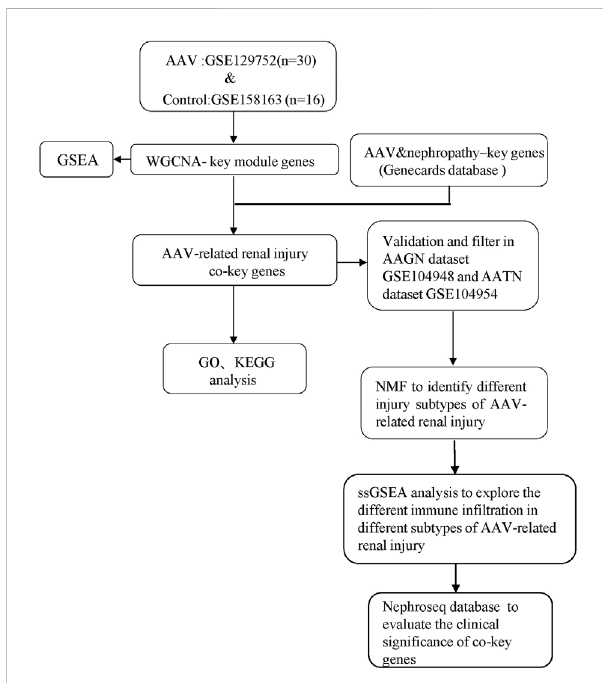
FIGURE 1 Study work fl ow. Anti-neutrophil cytoplasmic antibody – associated vasculitis (AAV), weighted gene co-expression network analysis (WGCNA), gene set enrichment analysis (GSEA), Gene Ontology (GO), Kyoto Encyclopedia of Genes and Genomes (KEGG), and non-negative matrix factorization